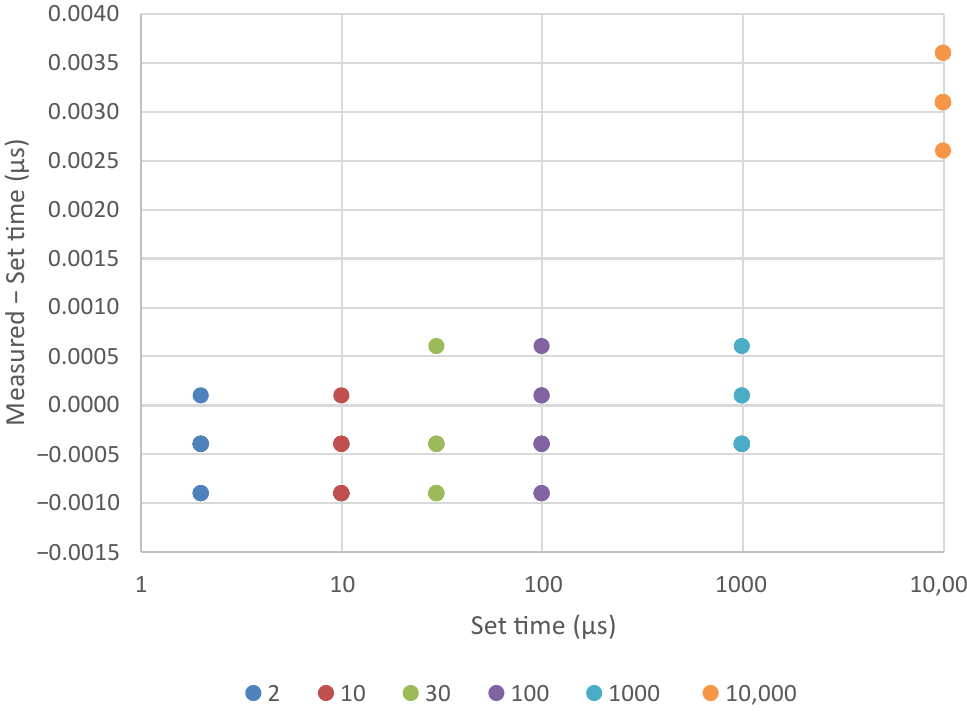
Figure 8. Set of 10 repeated measurements using OCXO (first six time delays).